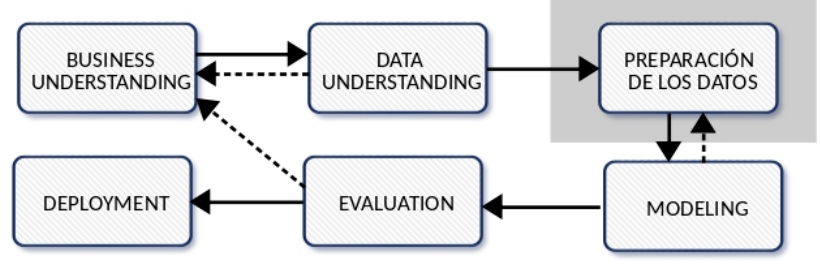
Figure 1. Classical methodology of a data mining